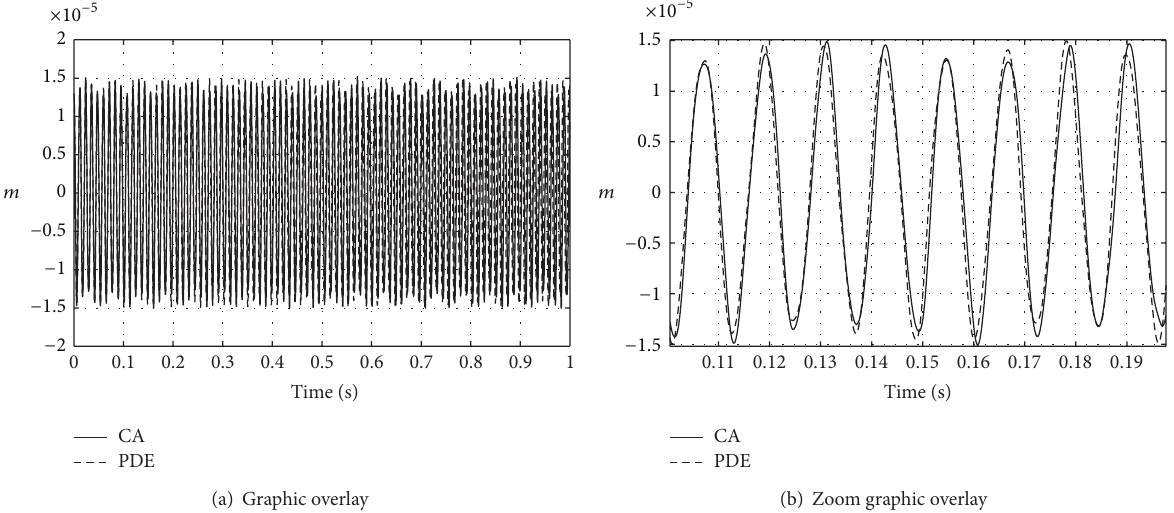
Figure 8: Overlay graphic (a) of the simulation realised by the CA and the PDE shows the displacement of the cell (𝑛/ 2 , 𝑛/ 2 ) on the 𝑧 -axis in both cases; (b) zoom-in graphic